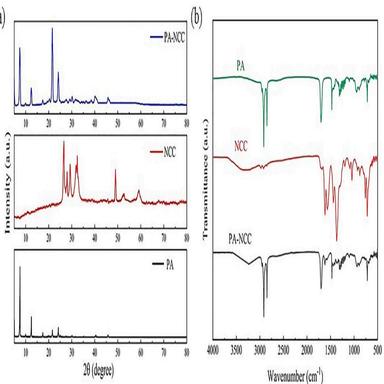
(a) XRD plots of PA, NCC, and PA-NCC; (b) FT-IR spectra of PA, NCC, and PA-NCC.